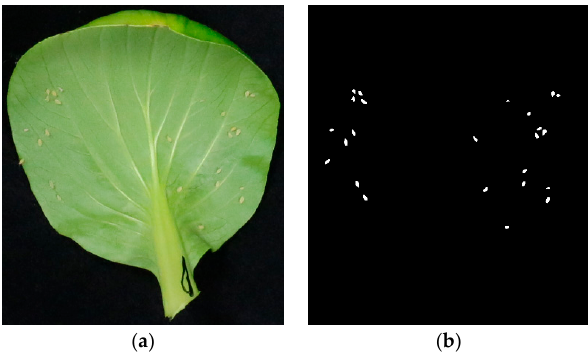
Figure 1. An example image of aphid nymphs on a leaf ( a ) and its corresponding annotation image ( b ).